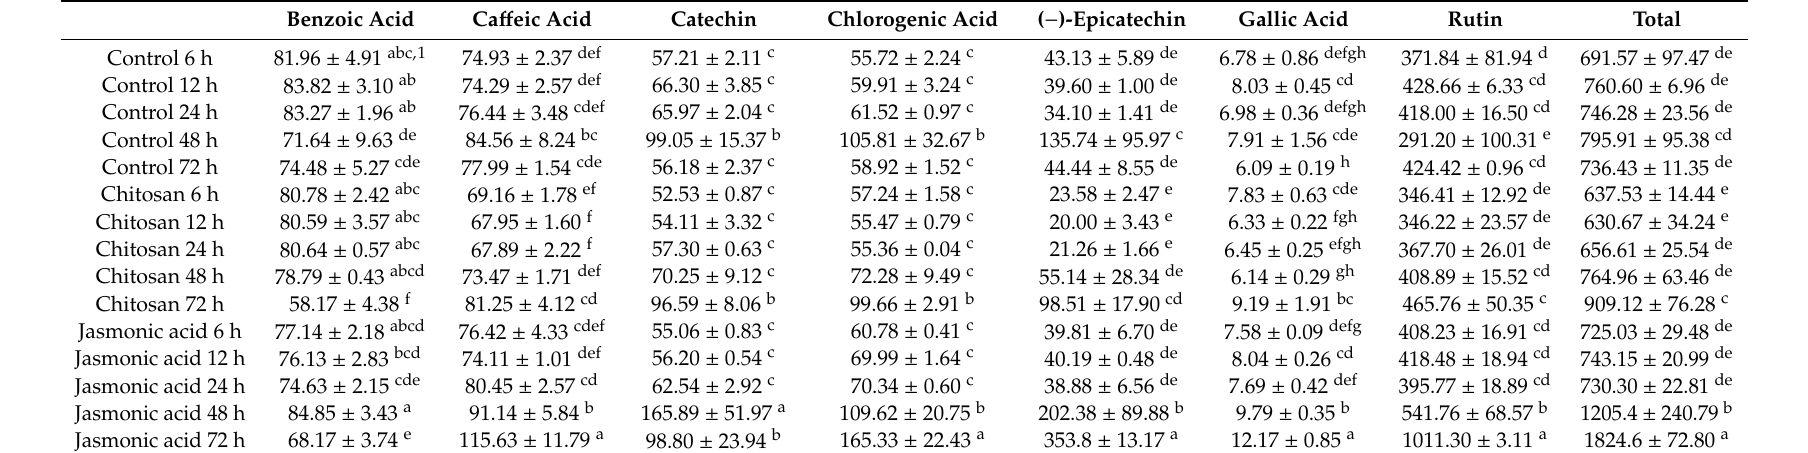
Table 2. High-performance liquid chromatography (HPLC) analysis of total phenolic compounds in the germinated buckwheat under 150 µ M jasmonic acid and 0.1% chitosan time-course treatment ( µ g / g